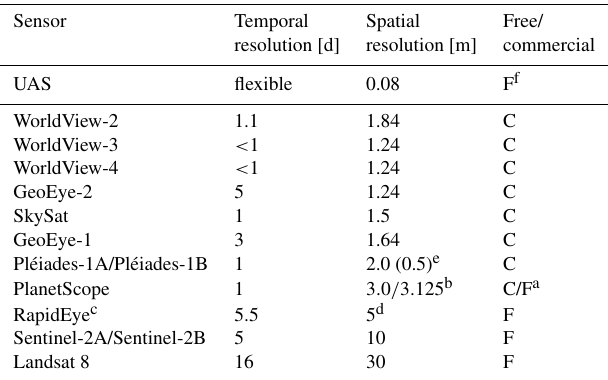
Table 1. Overview of different optical multispectral remote sensors with their corresponding resolution [m] and revisit rate [d]. The sen- sors are categorised into commercial and free data policy. Source: ESA